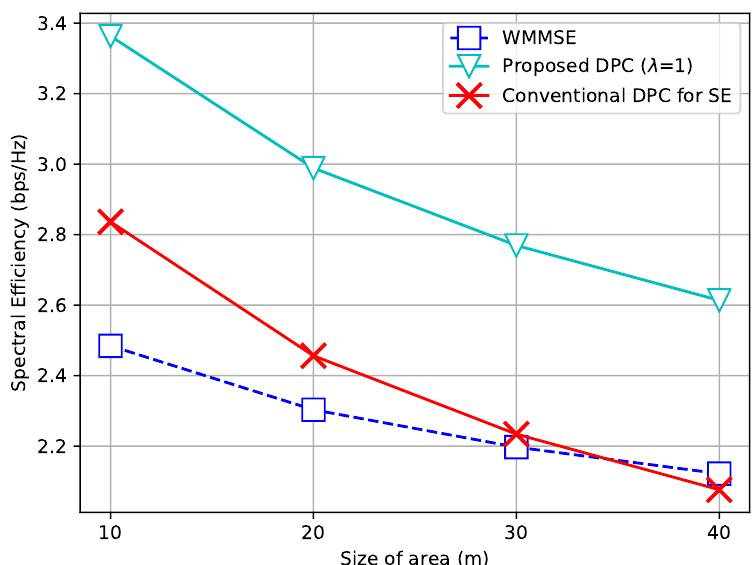
Figure 4. Average spectral efficiency of the conventional schemes and the proposed scheme for various area sizes in Rayleigh fading channels.